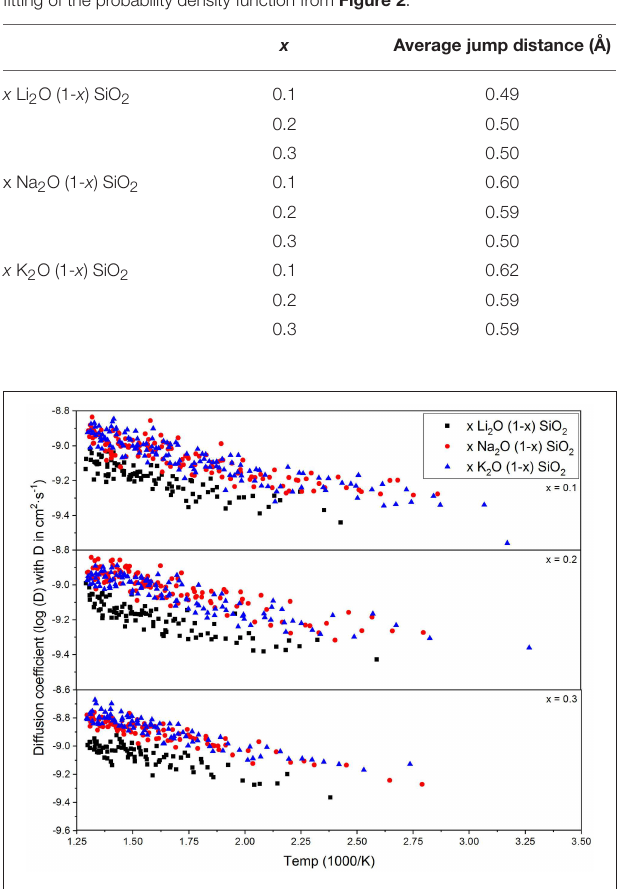
FIGURE 3 | Diffusion coefficient of the alkali ions calculated from equation (5) as a function of 1/T. The Arrhenius behavior is well-known for these glasses, being self-diffusion, or diffusion due to an external electric potential.